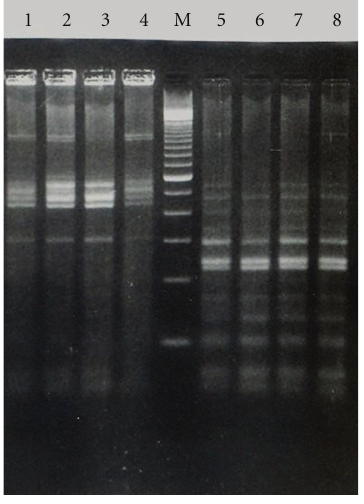
Figure 2: RFLP analysis of the PCR amplified MOMP gene from clinical specimens in 3% agarose